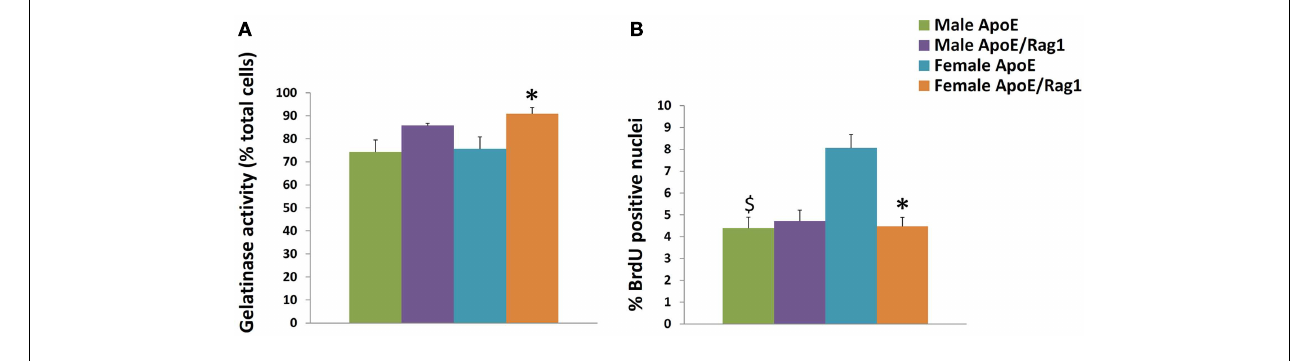
indicated. (A) In situ zymography (gelatinase activity, mean and SEM, n = 9–13). (B) Proliferative capacity (8h BrdU pulse, mean and SEM, n = 8–14). * P < 0.05 vs. DKO, $ P < 0.05 indicates gender differences for that